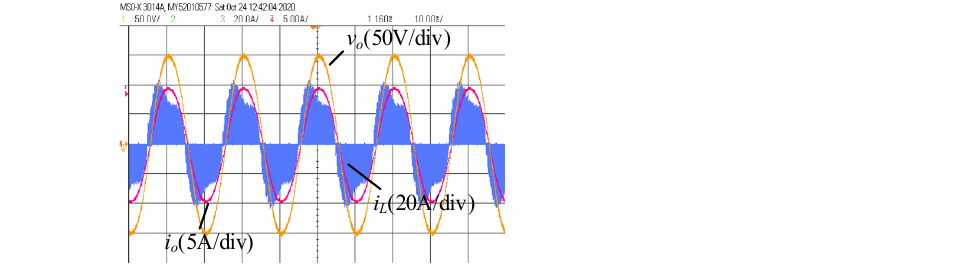
Figure 10. The voltage and current waveforms of the DCM inverter at P o = 0. Time: 10 ms/div. Figure 11. The voltage and current waveforms of the DCM inverter at P o = 1 kW. Time: 10 ms/div.